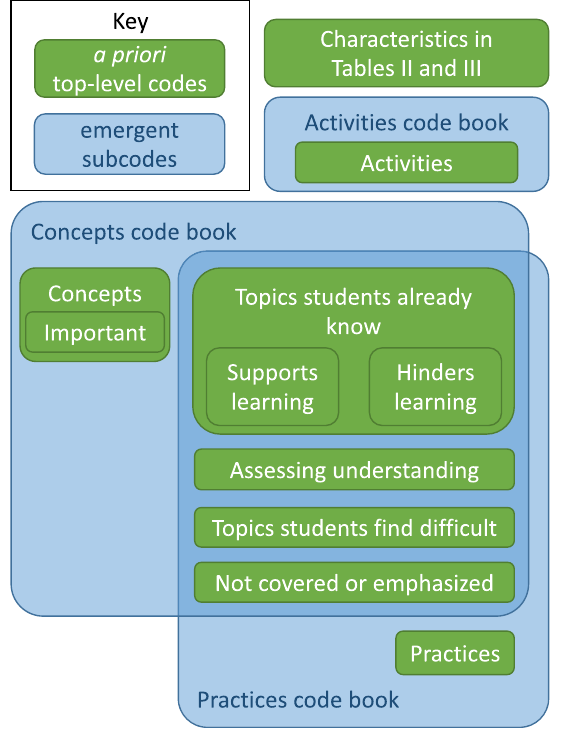
FIG. 1. A diagram illustrating our coding scheme. The green boxes represent the types of a priori codes that were applied in the first pass. These codes were used to identify excerpts for later analysis. The blue boxes represent the emergent codes that were applied in the second pass. In that pass, the excerpts pertaining to each green box were coded using the emergent code book(s) of the blue box(es) in which they appear in this diagram.